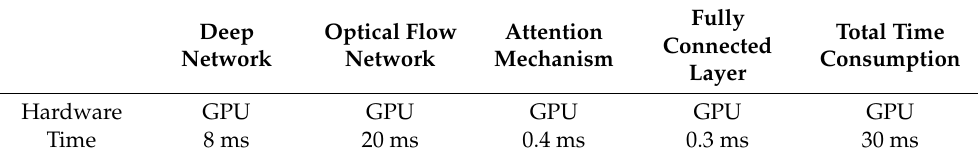
Table 9. Time consumption statistics for different